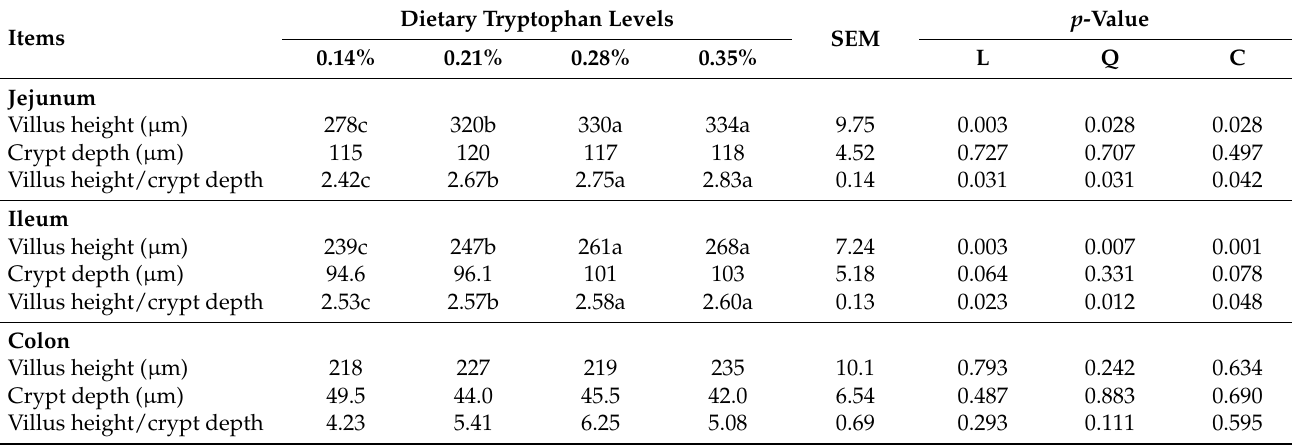
Table 4. Effects of dietary tryptophan levels on the morphology of the jejunum, ileum and colon mucosa of weaned